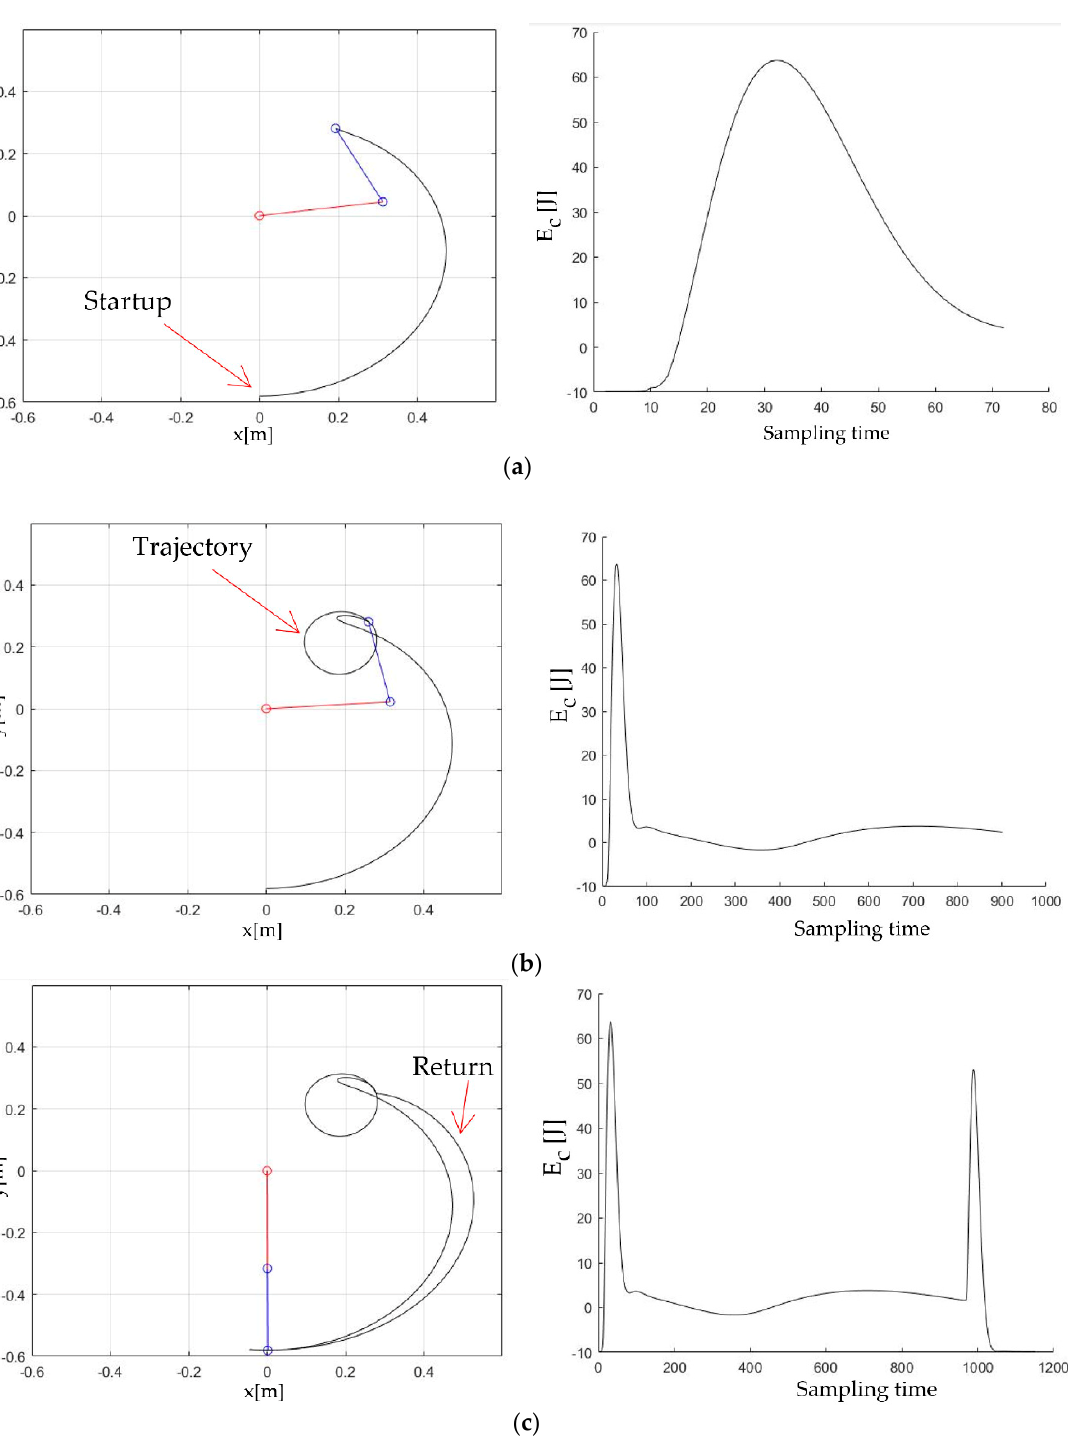
Figure 8. Required mechanical energy in the robot during the circular trajectory with and without the magnetic spring system . 5.2. Kinetic Energy Rotational Simulation To validate the power consumption, a kinetic energy rotational simulation is pro- posed; the simulation was developed in Working Model (version 5.1.2.53, San Mateo, CA,